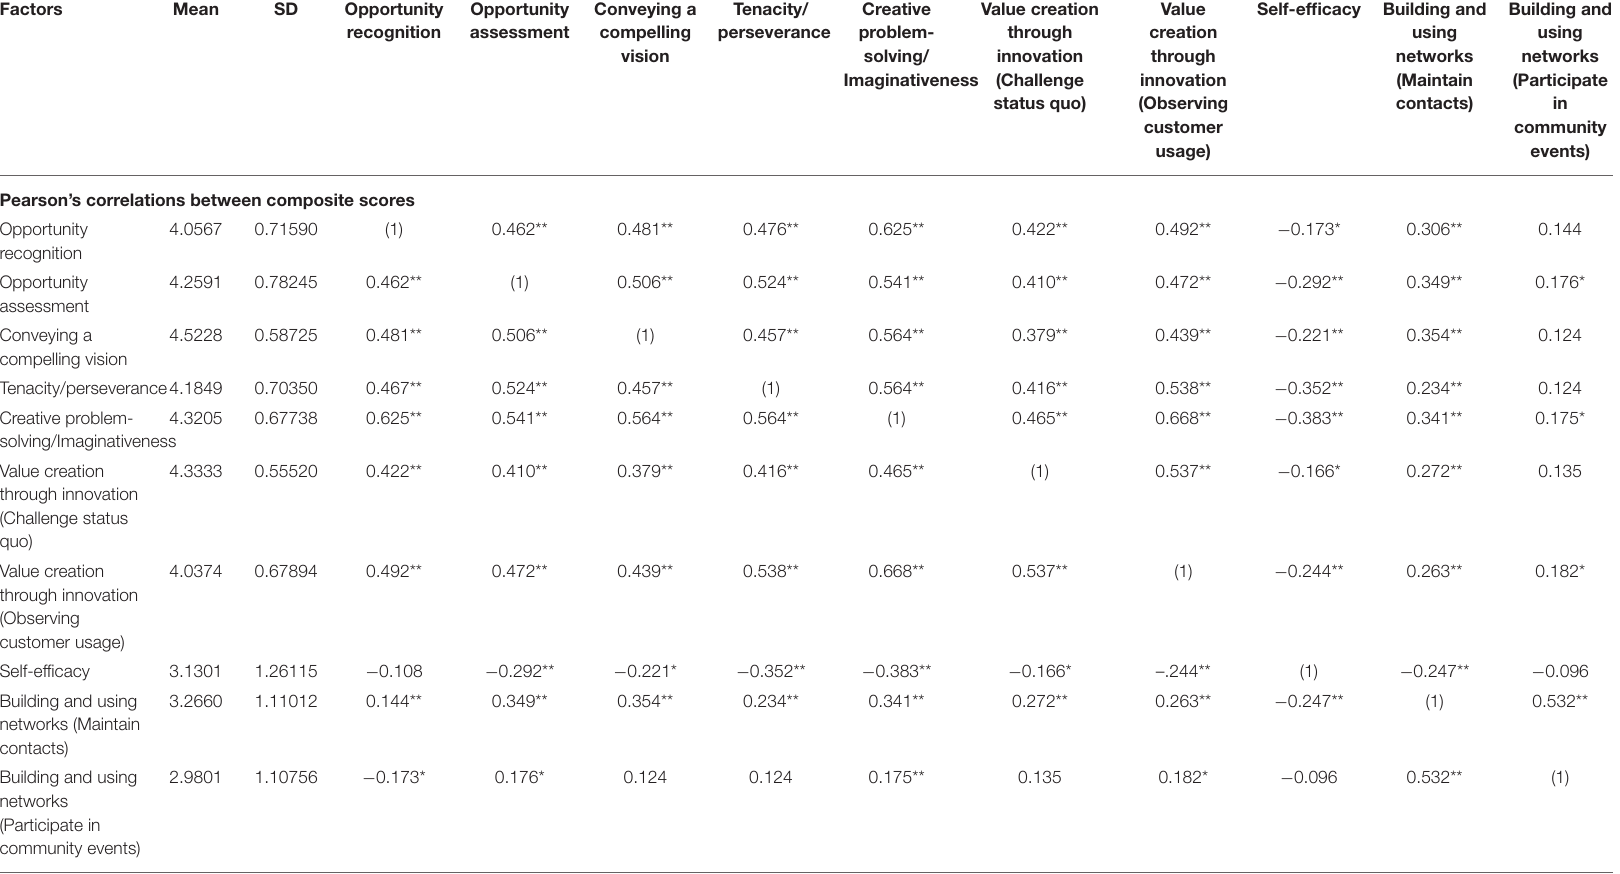
TABLE 3 | Descriptive statistics and correlations between the composite